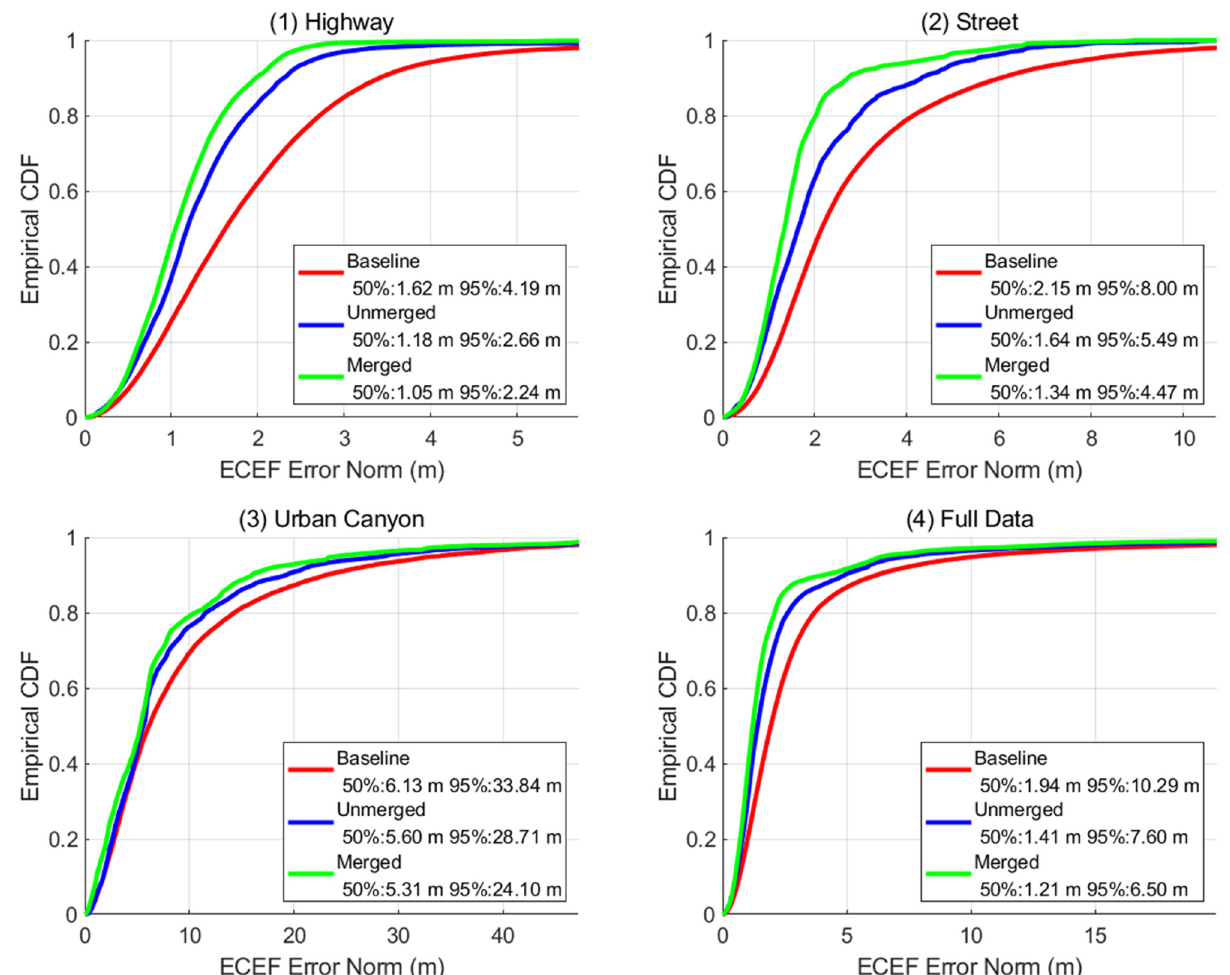
Figure 3. CDF plots of the performance of baseline solutions, unmerged RTKLIB solutions, and final merged solutions for each scenario and the entire training dataset: ( 1 ) Highway, ( 2 ) Street, ( 3 ) Urban Canyon, ( 4 ) Full Data. The unmerged RTKLIB solution was better than the baseline positions in all scenarios, and the merge further improved the accuracy of the RTKLIB solution.